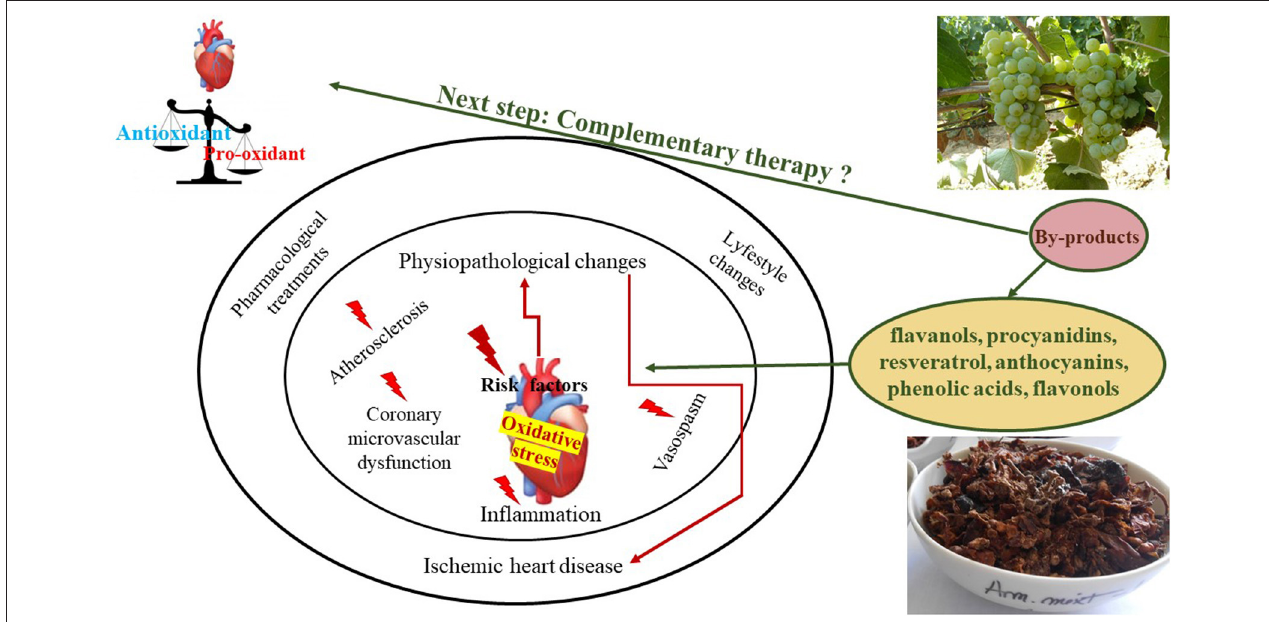
FIGURE 5 | Grapevine and wine by-products antioxidant/pro-oxidant influence on ischemic heart disease risk factors.